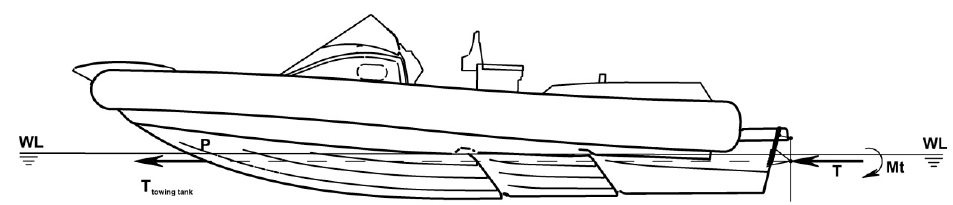
Figure 8. The down-thrust method: towing tank thrust and true force system applied on the hull.